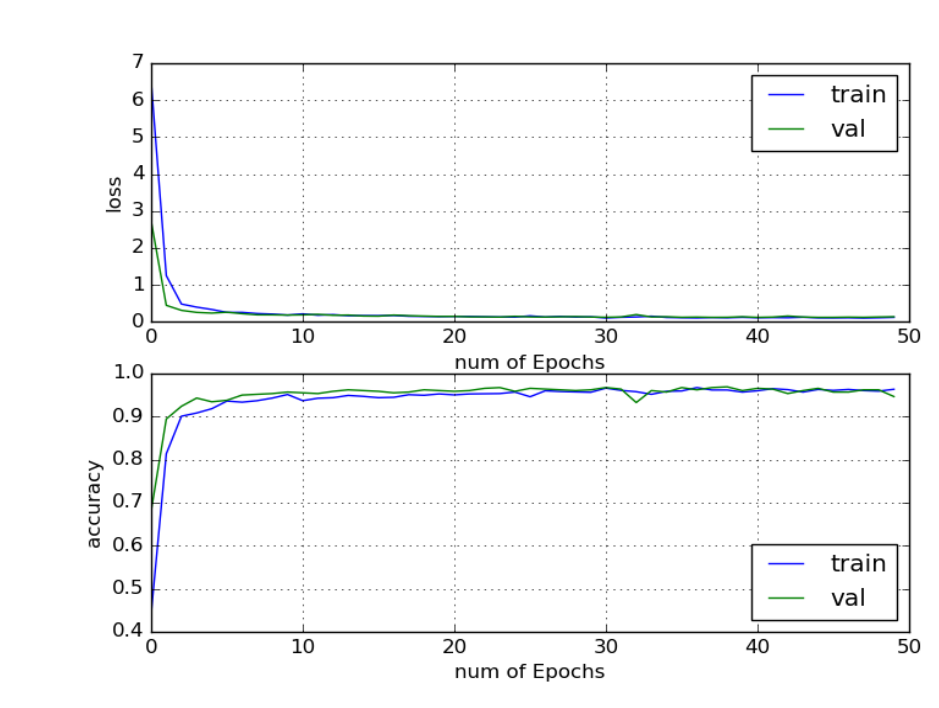
Figure 10. Fine tune DHCD model on Kaggle Devanagari numeral dataset using SGD optimizer.